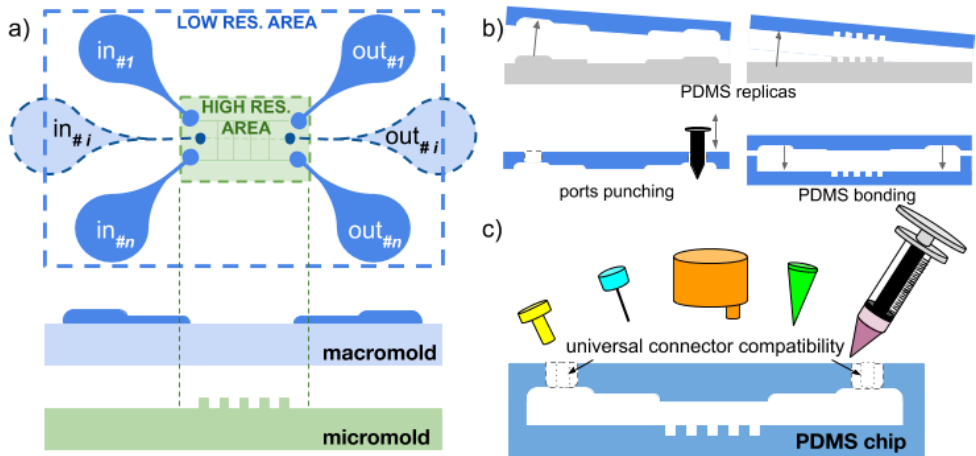
Figure 1. General principle of the Micro–macro process. ( a ) interconnect layouts are made in a macromold using low-resolution techniques while micron-scale features are designed and fabricated apart; ( b ) both molds are then replicated in polydimethylsiloxane (PDMS) and bonded together to create a single chip integrating both micro- and macro-features; ( c ) the ports (inlets and outlets) can be designed as a unique footprint with n available openings shared between multiple common microchannel designs. The openings may be designed sufficiently large in order to be compatible with any microfluidics connector (luers, reservoirs, micropipette tips, syringes, etc.).